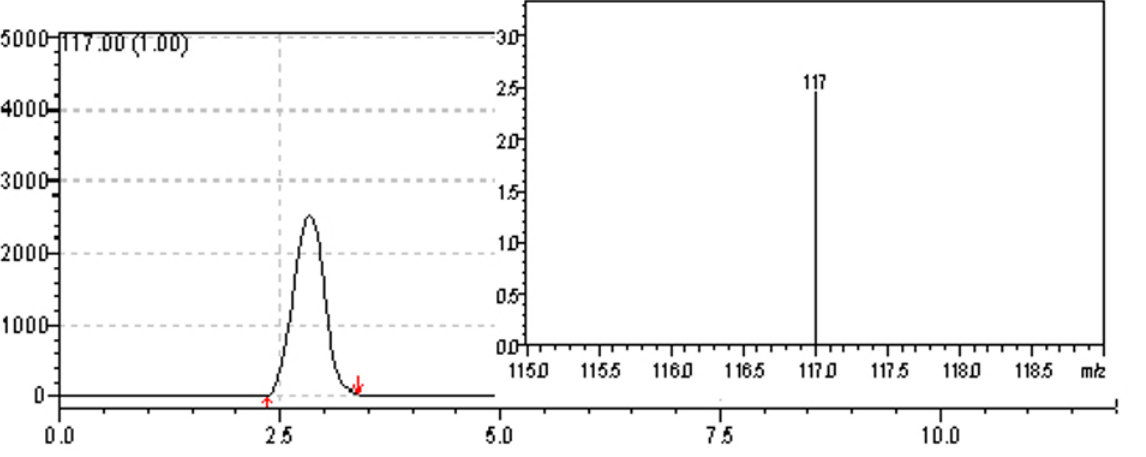
Figure 4. Ion chromatogram and signal intensity for succinic acid standard